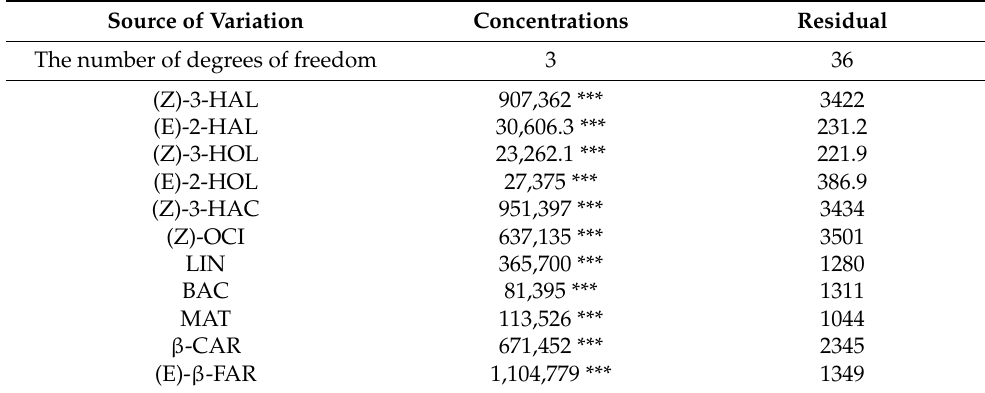
Source of Variation